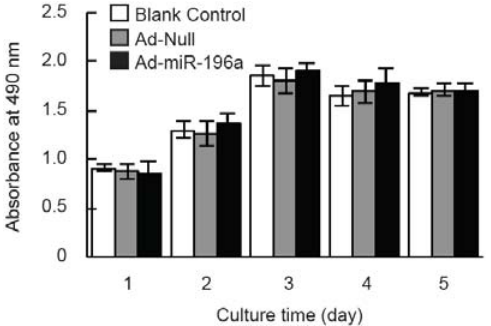
Figure 4. Proliferation of porcine preadipocytes accessed by MTT assay. Porcine preadipocytes infected with Ad ‐ miR ‐ 196a or Ad ‐ Null were cultured for 5 days, cell proliferation was assessed with MTT assay, normal cells as blank control ( n = 12 in each group), p < 0.05 was considered as statistically significant.